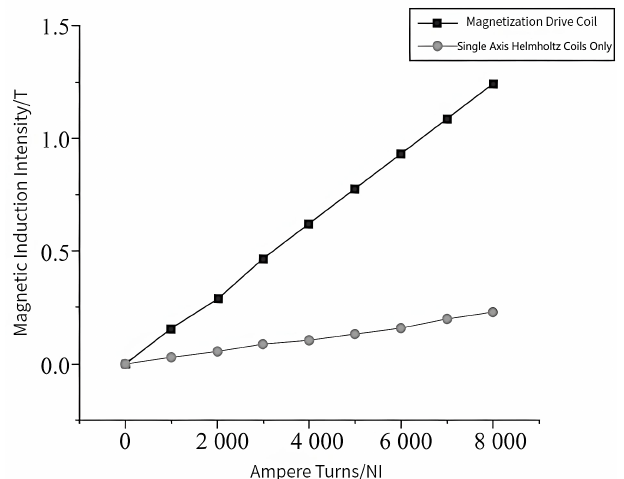
Figure 12. Comparison of the magnetic induction intensity characteristic curves of magnetized drive coils and Single-Axis Helmholtz Coils Only.